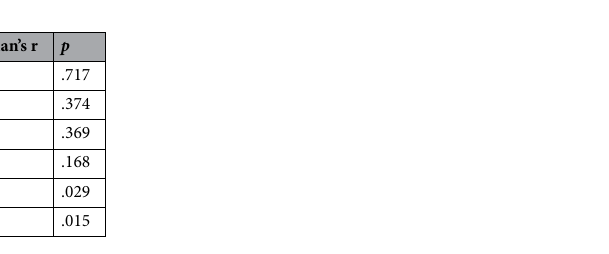
Table 4. Correlation between plasma neurotransmitter levels and bacterial diversity indices in IBS people.